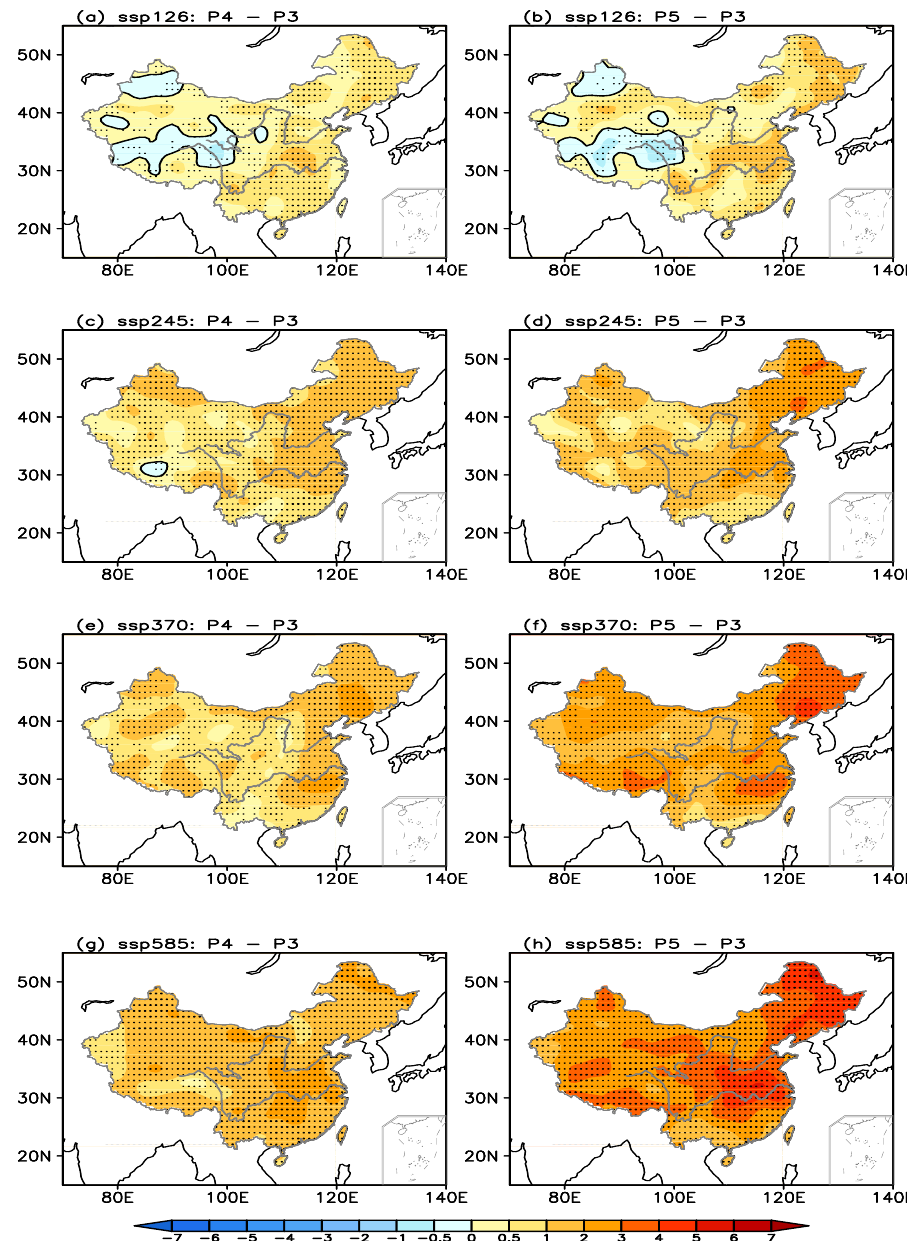
Fig. 9 Same as Fig. 7 but for